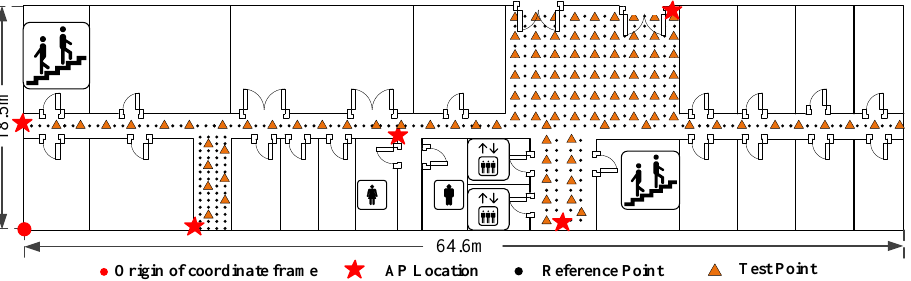
Figure 18. Testbed for static localization.